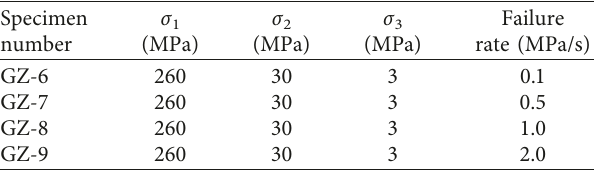
Table 3: Testing plan of one-single face true-triaxial unloading test with different support failure